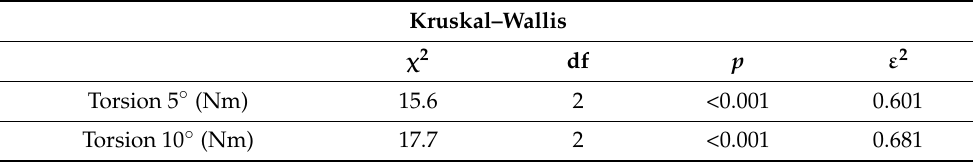
Table A5. Results of the Kruskal–Wallis tests for the different fixation methods (Group I, II, and III)